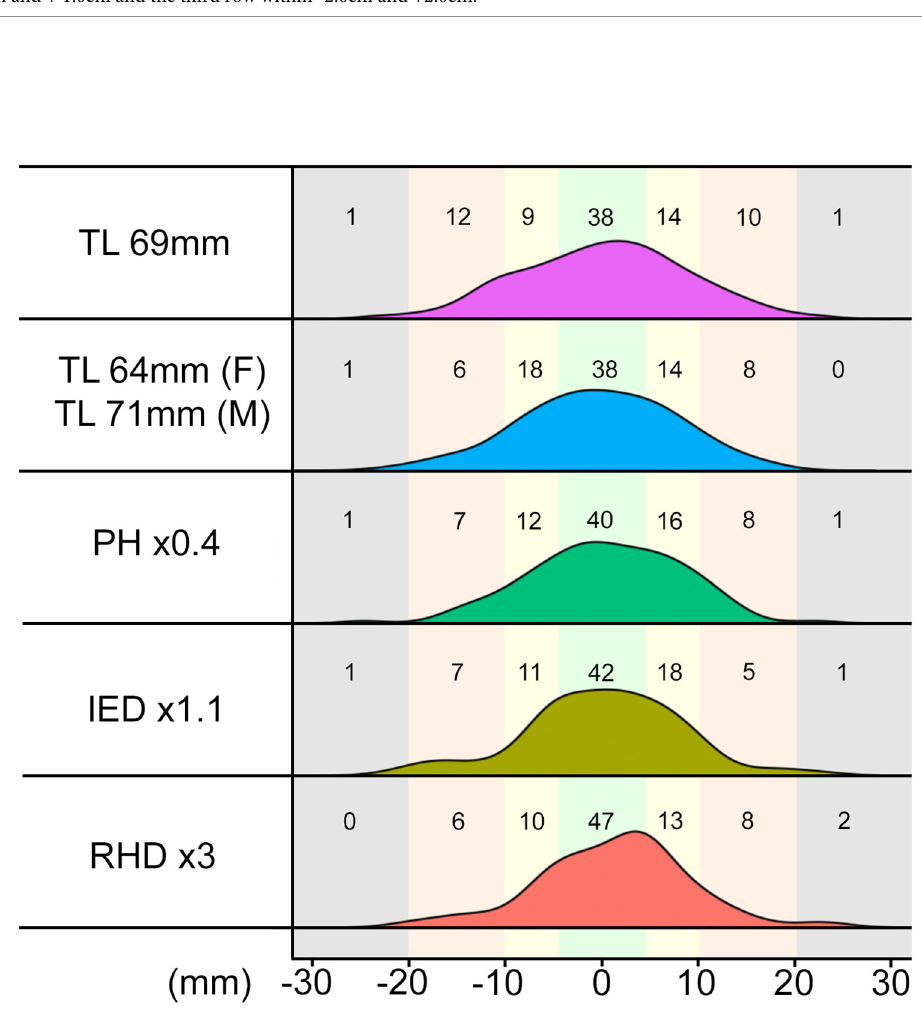
Fig 6. Distal biceps tendon length prediction by. This histogram shows the tendon length prediction by mean tendon length (TL; mean value 69mm), mean tendon length with gender distinction (TL; F Female mean value 64mm, M Male mean value 71mm), patient’s heigth (PH in cm x0.4), inter-epicondylar distance (IED in mm x1.1) and radial head diameter (RHD in mm x3). The scale reaches from 0 to -30mm (left) and +30mm (right). Perfect match would be a value of 0. And positive values imply that the calculated tendon assumes a too long, negative values too short. For example, the calculated tendon by RHD tends to be rather longer (23 elbows > +0.5cm) than smaller (16 elbows <